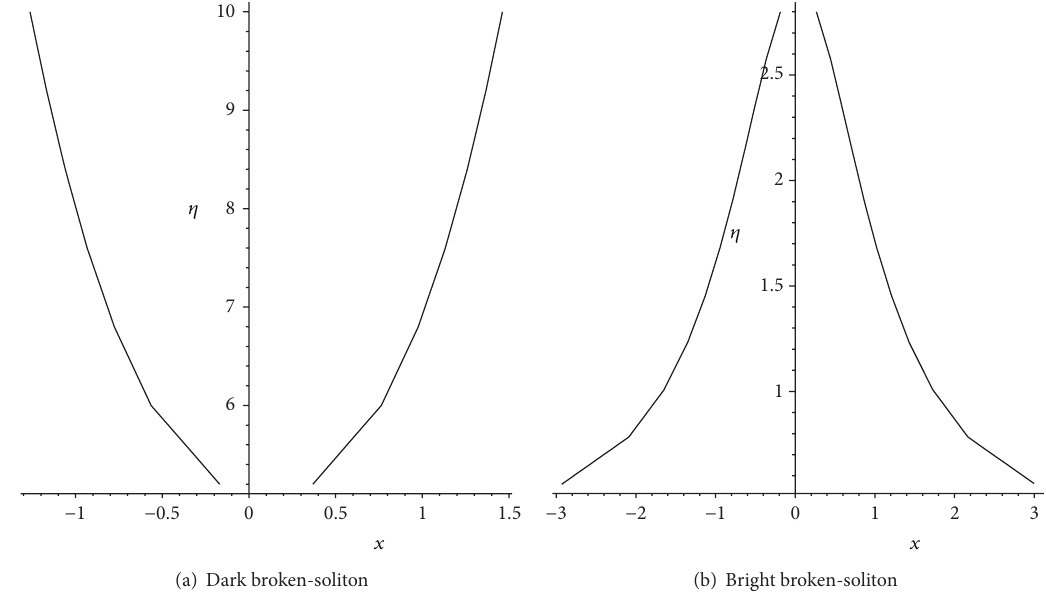
Figure 1: The graphs of solutions (19) and (39) under some fixed parametric